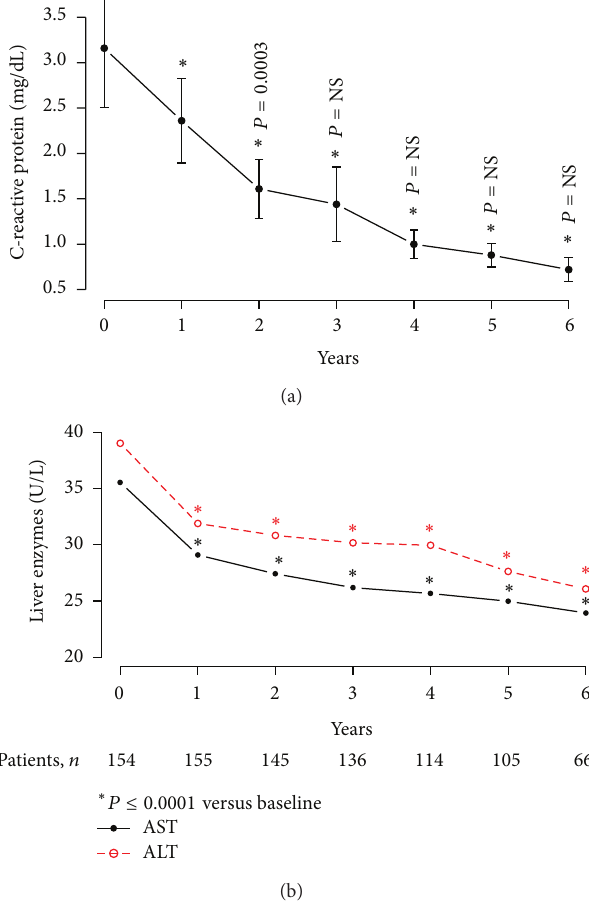
Figure 10: (a) C-reactive protein (mg/dL); (b) liver enzymes aspartate transaminase and alanine transaminase (U/L) in 156 obese hypogonadal men with type 2 diabetes treated with testosterone undecanoate injections for up to 6